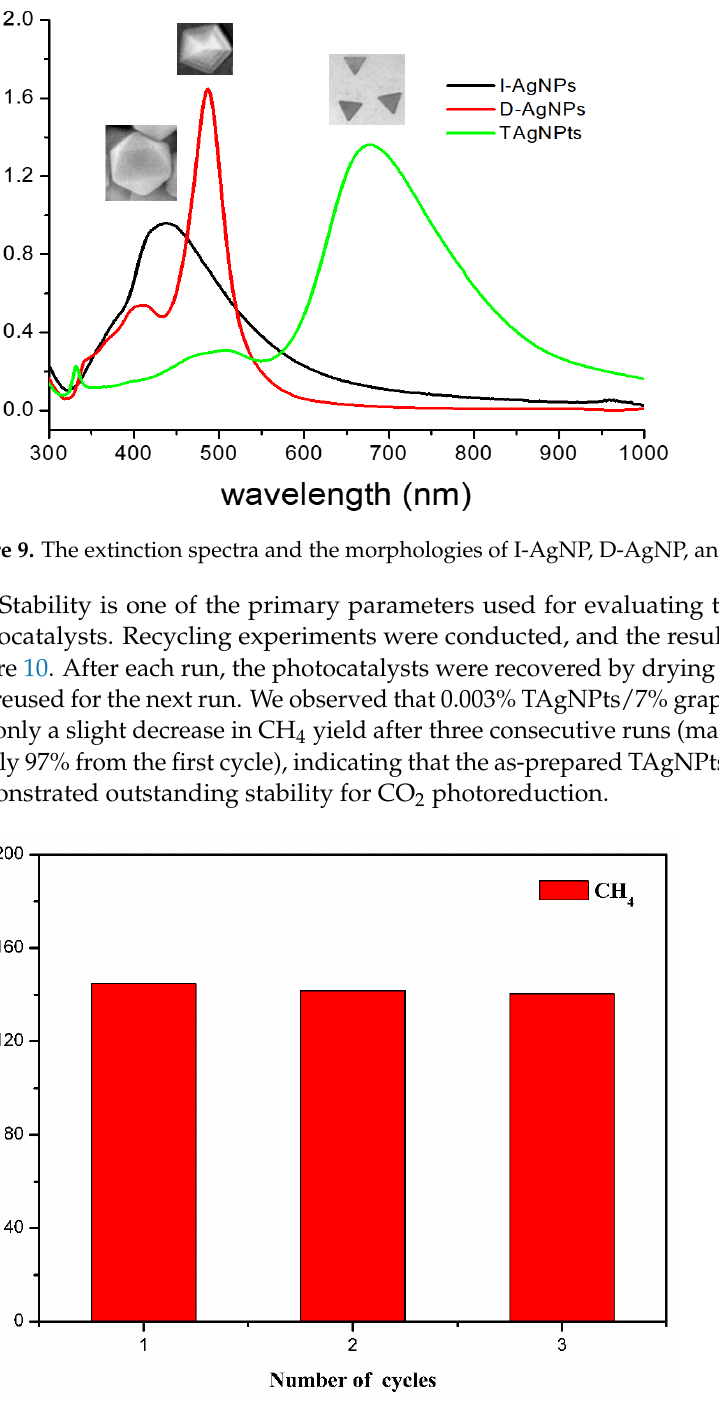
Figure 10. Recycling stability tests over the as-obtained 0.003%TAgNPt/7% graphene/BiVO 4 .